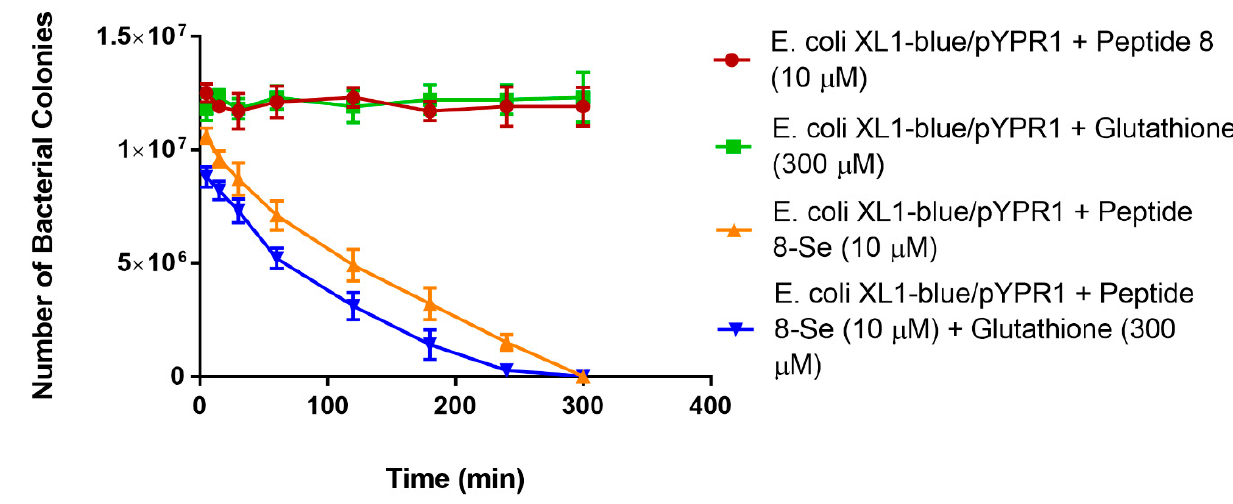
Figure 6. The effect of seleno-peptide #8 (10 µM) on the E. coli XL1-blue/pYPR1 strain, with or without glutathione, under added oxygen at 4 °C. Values represent the mean from three independent experiments.